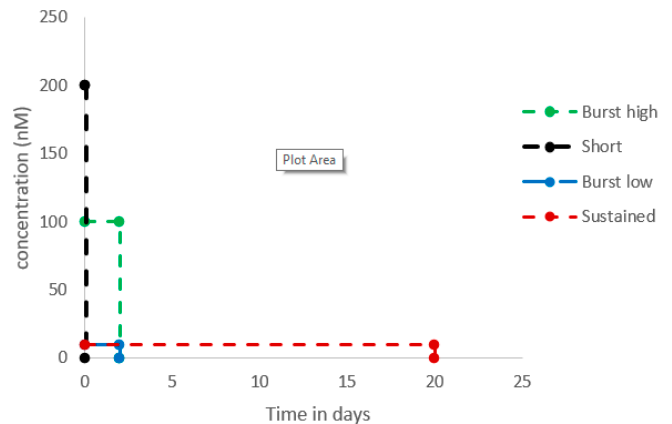
Figure 1. Schematic representation of the di ff erent vitamin D 3 applications. A total of 124 ng of vitD 3 was added for either 30 min before seeding at a concentration of 200 nM (Short), for two days at a concentration of 100 nM (Burst high) to mimic a burst release, or for 20 days with a concentration of 10 nM (Sustained) to mimic a sustained release. Alternatively, cells were exposed to 10 nM vitD 3 for two days (Burst low).